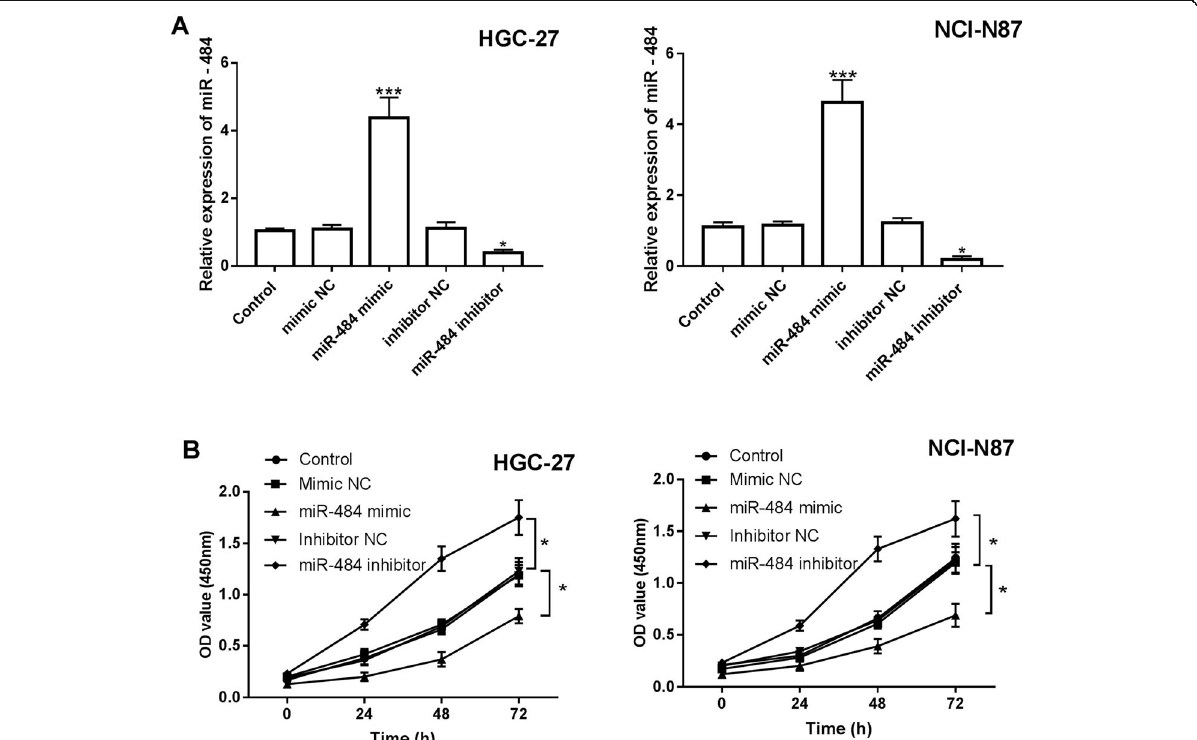
Fig. 3 Effect of miR-484 on the cell proliferation of HGC-27 and NCI-N87. a . Expression of miR-484 in the presence of miR-484 mimic or miR-484 inhibitor (* P < 0.05, *** P < 0.001). b . Overexpression of miR-484 inhibited the proliferation of gastric cancer cells (* P <